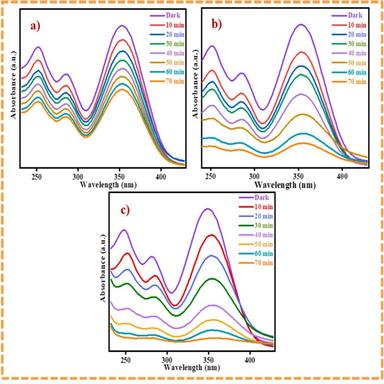
The absorption spectra of brexin in the presence of (a) NF-ldh (b) NF-ldh/gCN (c) NF-ldh/MXene.